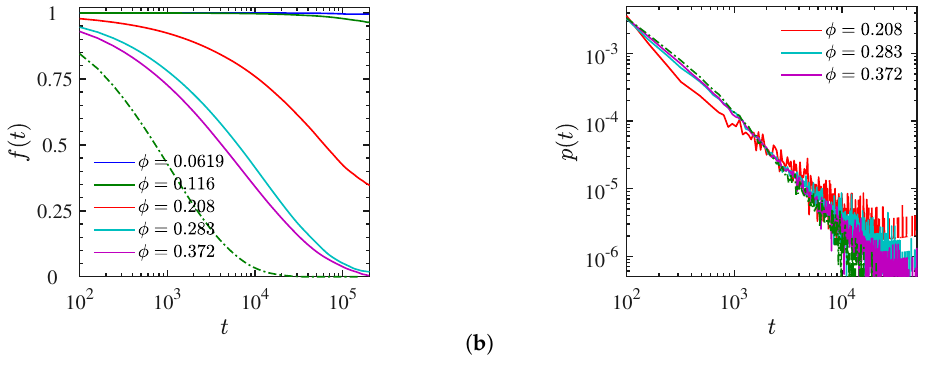
Figure 10. ( a ) Survival probability f ( t ) of a polymer–NP crosslink to remain intact at t given that it already existed at an arbitrary reference time t = 0. ( b ) The corresponding temporary crosslink lifetime (cid:82) p ( t ) dt = 1 over the simulation timespan. Data shown for all distribution p ( t ) , normalized such that dispersed systems of N = 200 containing p3-charged chains forming either ‘temporary’ or ‘apparent’ crosslinks in ( a ), and only liquid-like systems with temporary crosslinks in ( b ). Dash-dotted lines in ( a ) and ( b ) correspond to a end-charged system at φ =